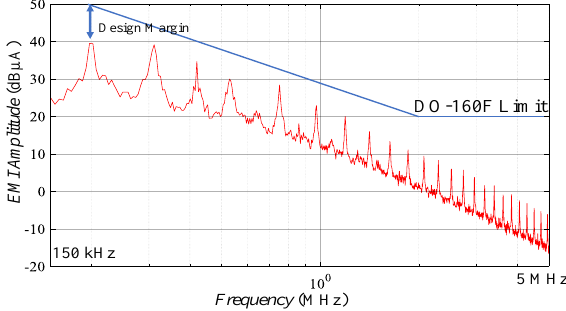
Figure 8. Simulated DM Noise Spectrum after filtering action.